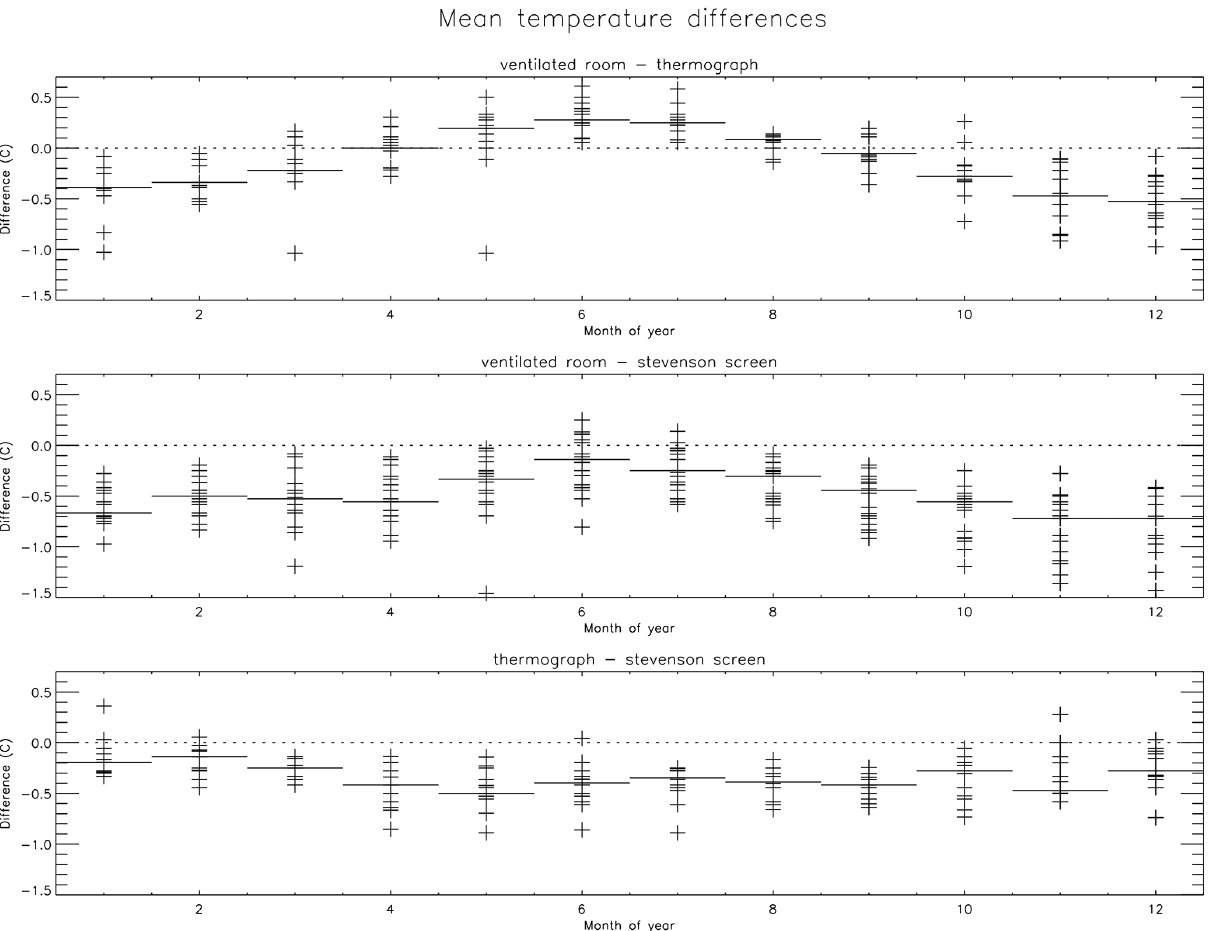
Figure 18. As Fig. 12 but for Tm. All axes are the same range but differ from those given in Figs. 12, 14, and 16. As in Fig. 17 the series utilizes a combination of self-calculated and reported values for